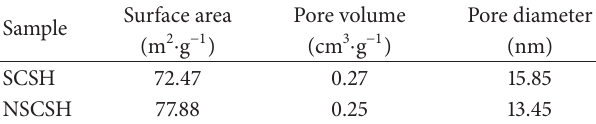
Table 4: The structure characteristics of